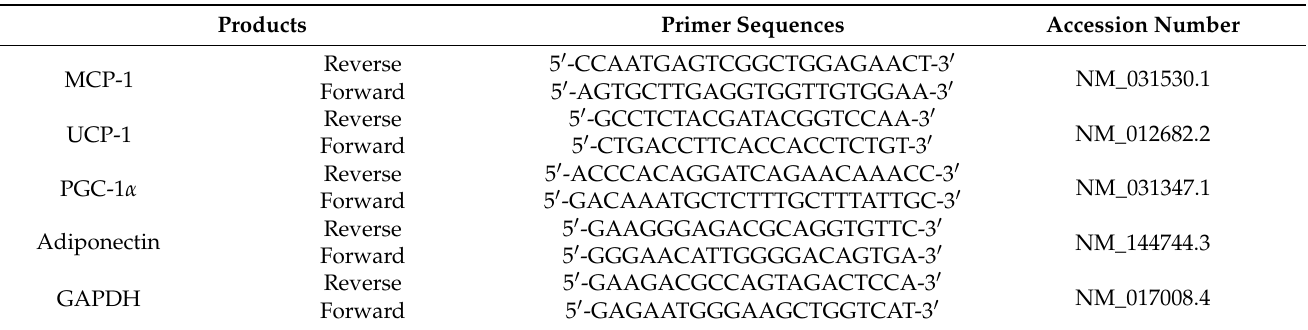
Table 2. Primer sequences for quantitative polymerase chain reaction. MCP-1: monocyte chemo- tactic protein-1, UCP-1: uncoupling proein-1, PGC-1 α : peroxisome proliferator activated receptor